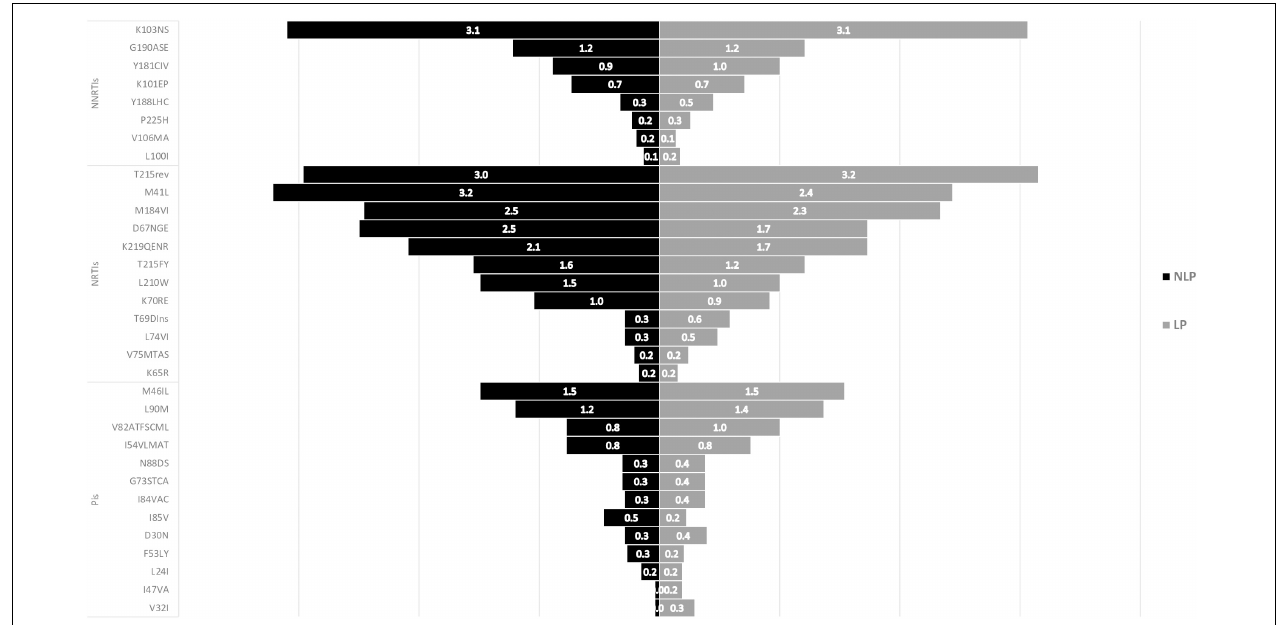
FIGURE 4 | ART-naïve mutations in Non-Late-Presenters (NLP) vs Late Presenters (LP). PIs, protease inhibitors; NRTIs, nucleoside reverse transcriptase inhibitor; NNRTIs, non-nucleoside reverse transcriptase inhibitor.